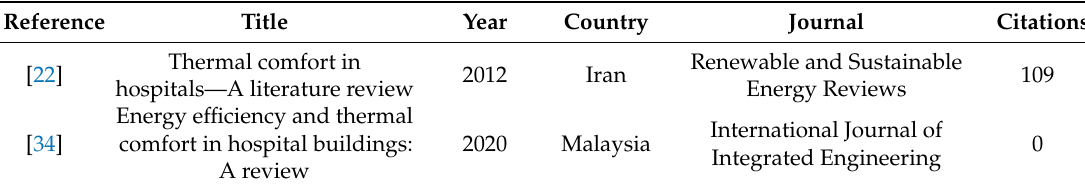
Table 3. Literature